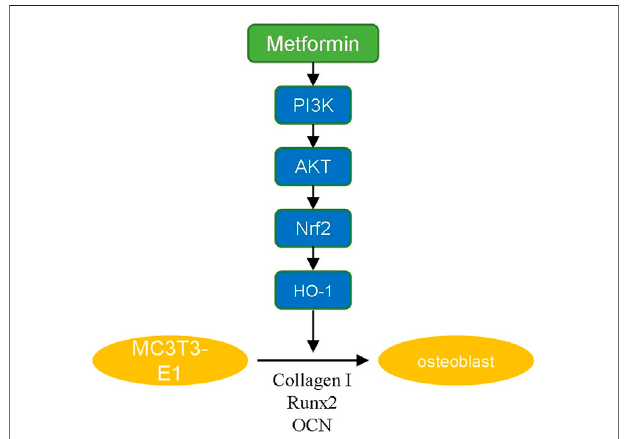
FIGURE 5 | The summarized fi gure of signaling